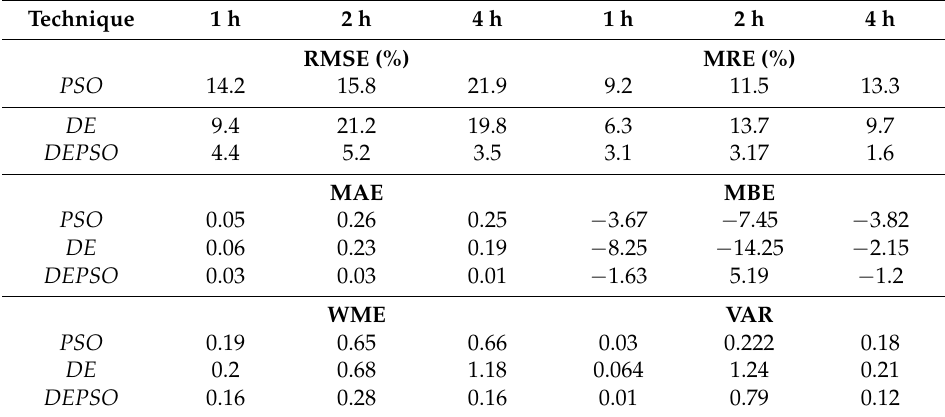
Table 5. Calculated error values for the DE, PSO, and proposed DEPSO